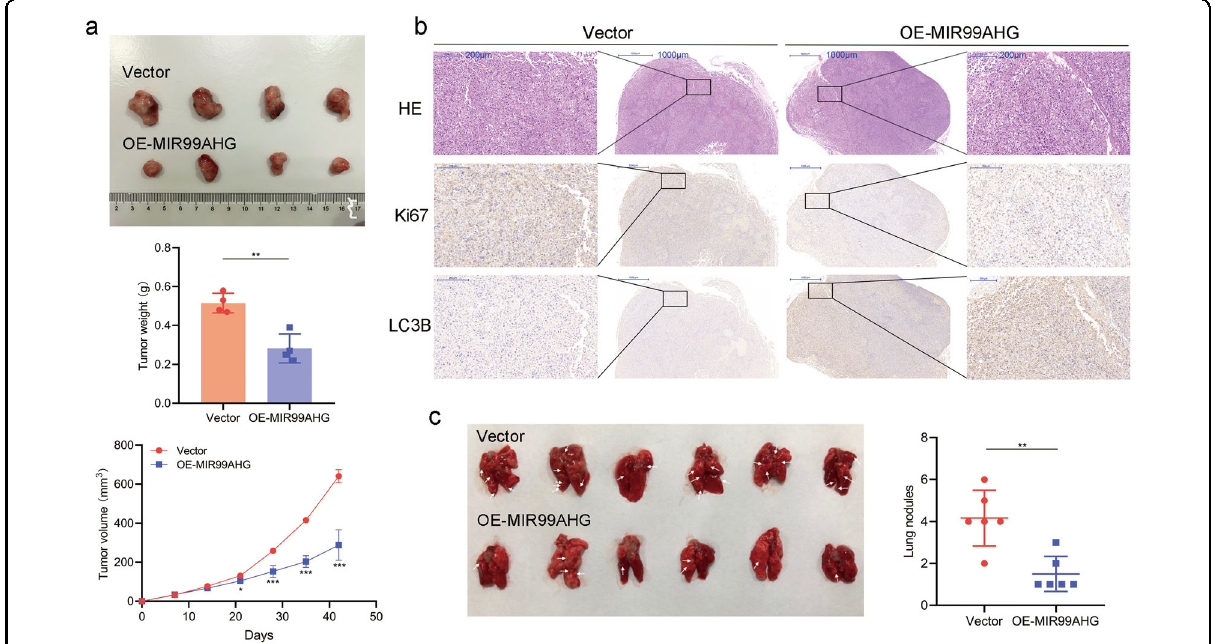
Fig. 4 MIR99AHG inhibits tumor progression in LUAD in vivo. a H1299 cells transfected with the MIR99AHG overexpression plasmid or empty vector were subcutaneously transplanted into nude mice. The subcutaneous tumors at the experimental endpoint are shown. The weight and volume of subcutaneous xenograft tumors are indicated ( n = 4). b IHC staining of LC3B and Ki67 performed on xenograft tumors from the nude mice. c H1299 cells after transfection were injected into the tail veins of nude mice. Lungs from mice in each experimental group, with the numbers of tumor nodules on lung surfaces, are shown. White arrows indicate the tumor nodules on lung surfaces. A two-tailed Student ’ s t -test was used for statistical analysis. * P < 0.05, ** P < 0.01, *** P < 0.001. Error bars,